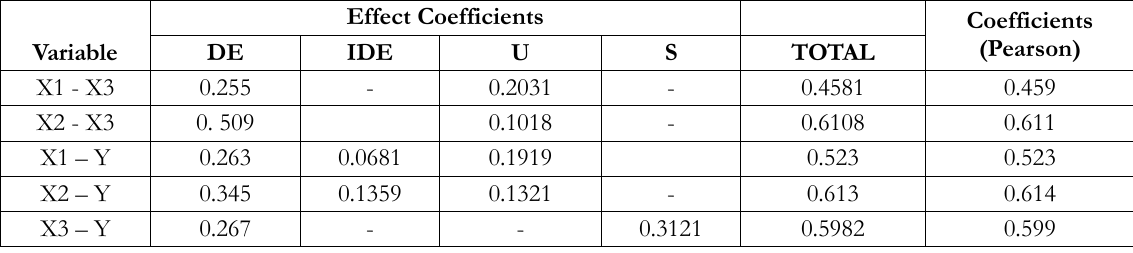
Table 9. Calculation results of path testing, and the indirect effect of the